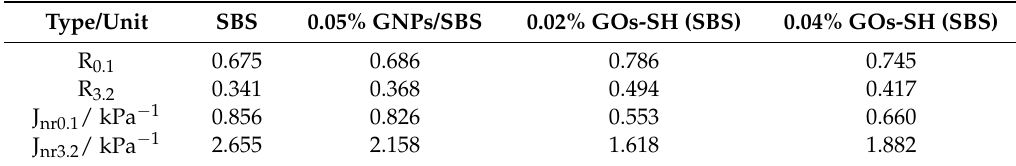
Table 2. R and J nr of various samples at 0.1 KPa and 3.2 KPa.